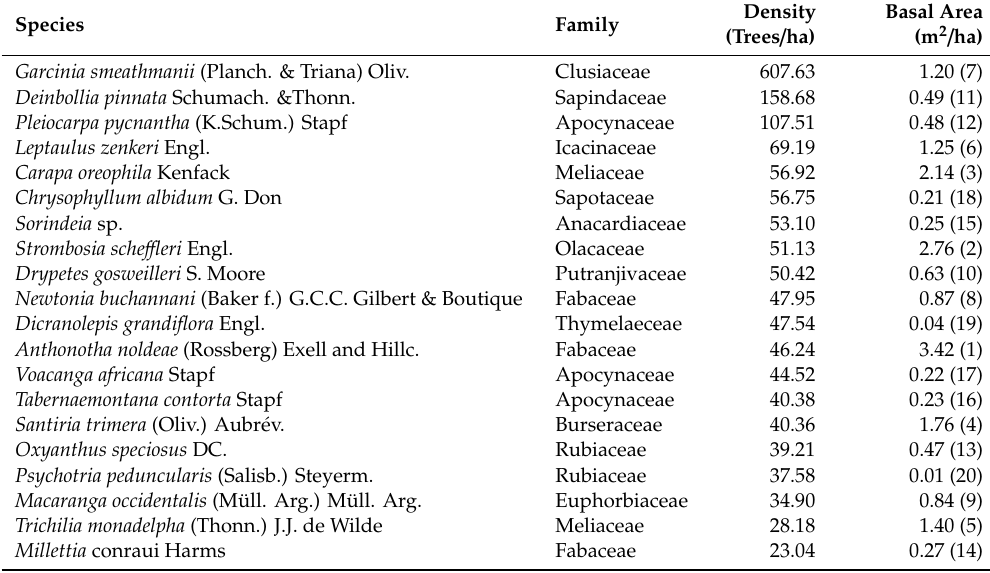
Table 2. The twenty most abundant woody plant species in the Ngel Nyaki plot, ranked by density. The rank corresponding to their basal area is indicated in